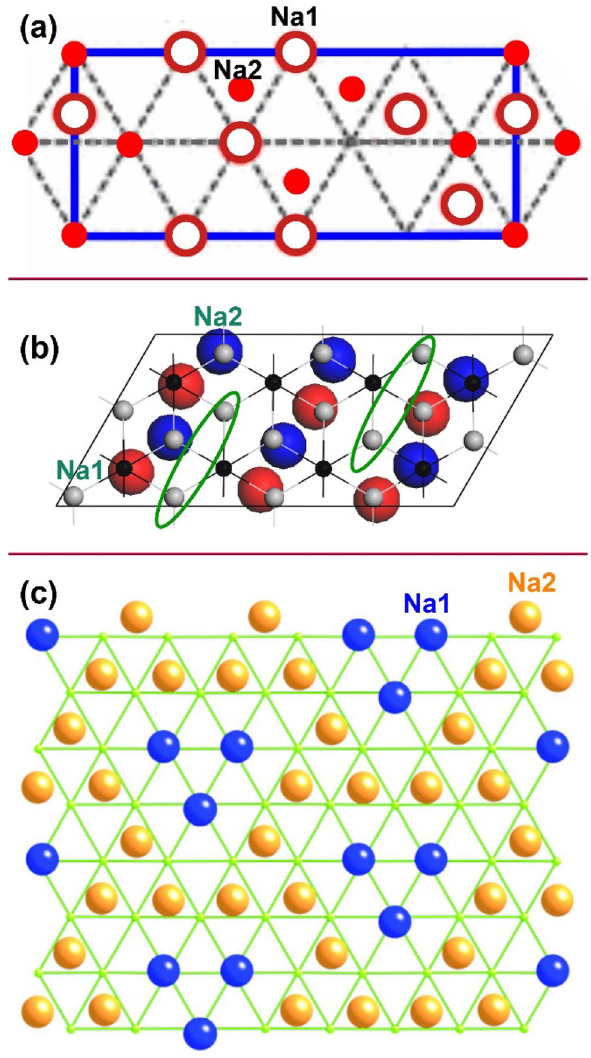
Fig. 6 The schematic presentation of Na ion arrangements in Na 0.75 CoO 2 calculated with different U eff values. a LDA calculations based on Zhang et al . [110]. The open circles denote those Na ions at Z = 0, while solid circles denote those Na ions at Z = 0.5 within the unit cell. b GGA + U ( U eff = 4 eV) calculations based on Assadi et al . [111]. Here, the color scheme is similar to that in Fig. 4. c GGA + U calculation based on Hinuma et al . [113] with U eff = 5 eV. Here, the Na ions at Z = 0 are at mirror locations of those at Z = 0.5. The blue and gold spheres rather denote Na1 and Na2. Adapted after Refs. [110, 111, 113]. Copyrights 2005 American Physical Society,